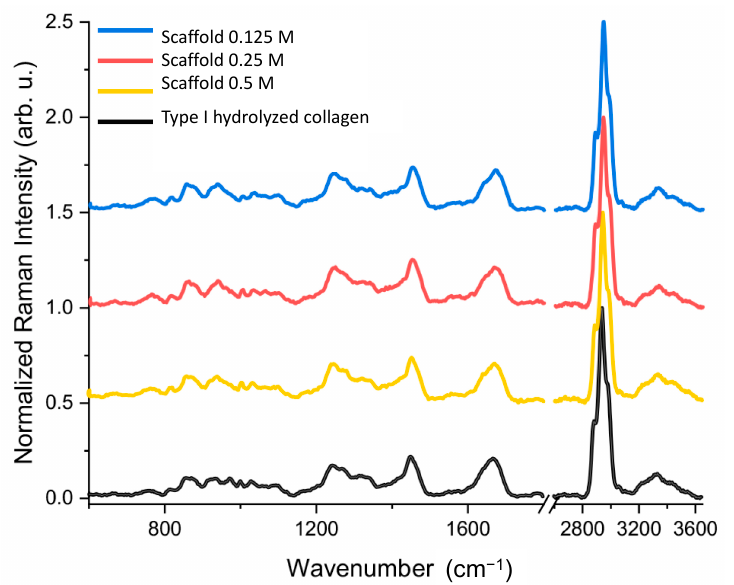
Figure 5. Raman spectra of previously prepared scaffolds with different treatments: blue (0.125 M), red (0.25 M) and yellow (0.5 M), as well as the type I hydrolyzed collagen as reference (dark). Representative Raman spectra, n > 3.